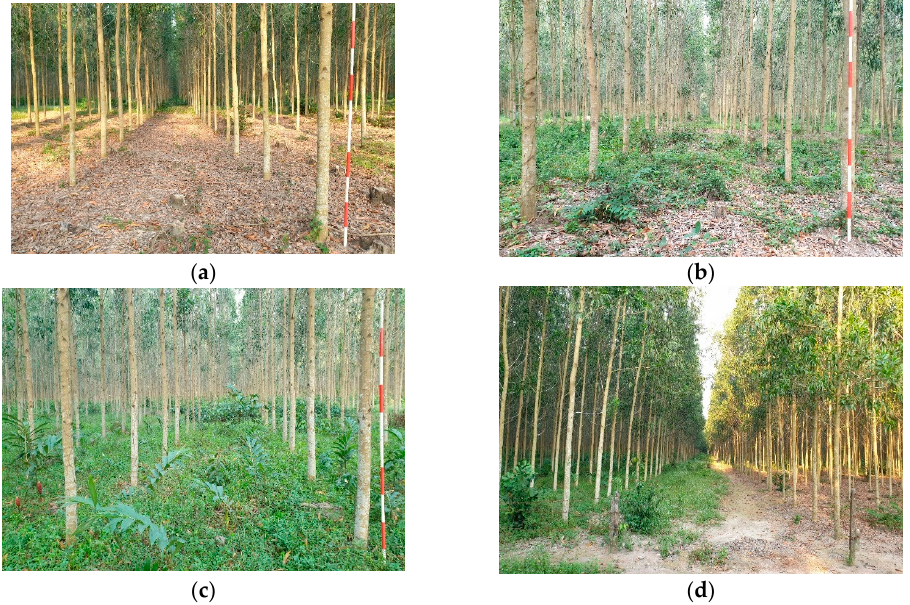
Figure 5. Variations in understory developed in a fourth rotation A. auriculiformis stand at three